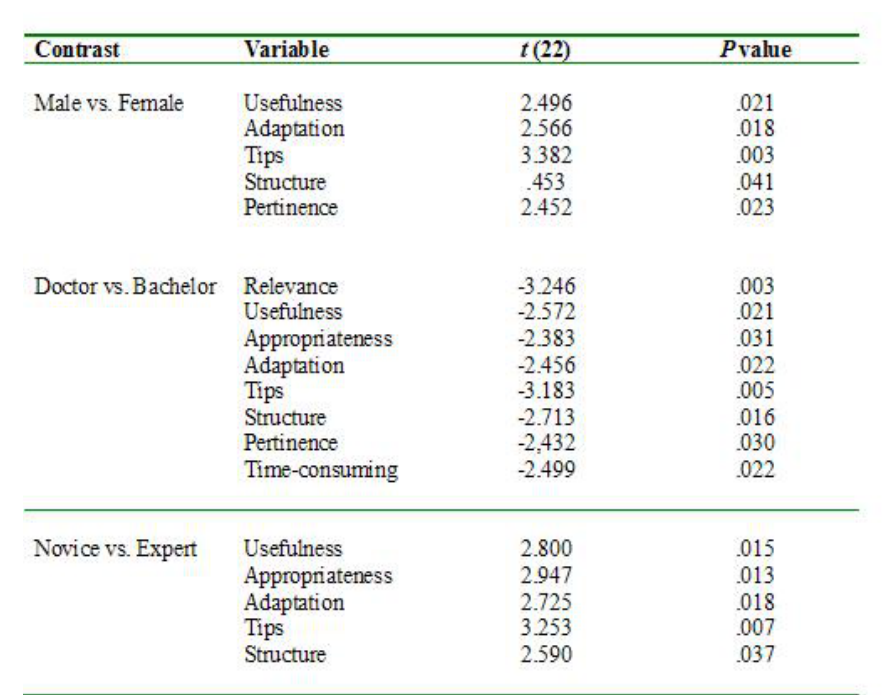
Table 3. Significant t-Test Results for Demographic and Academic Factor